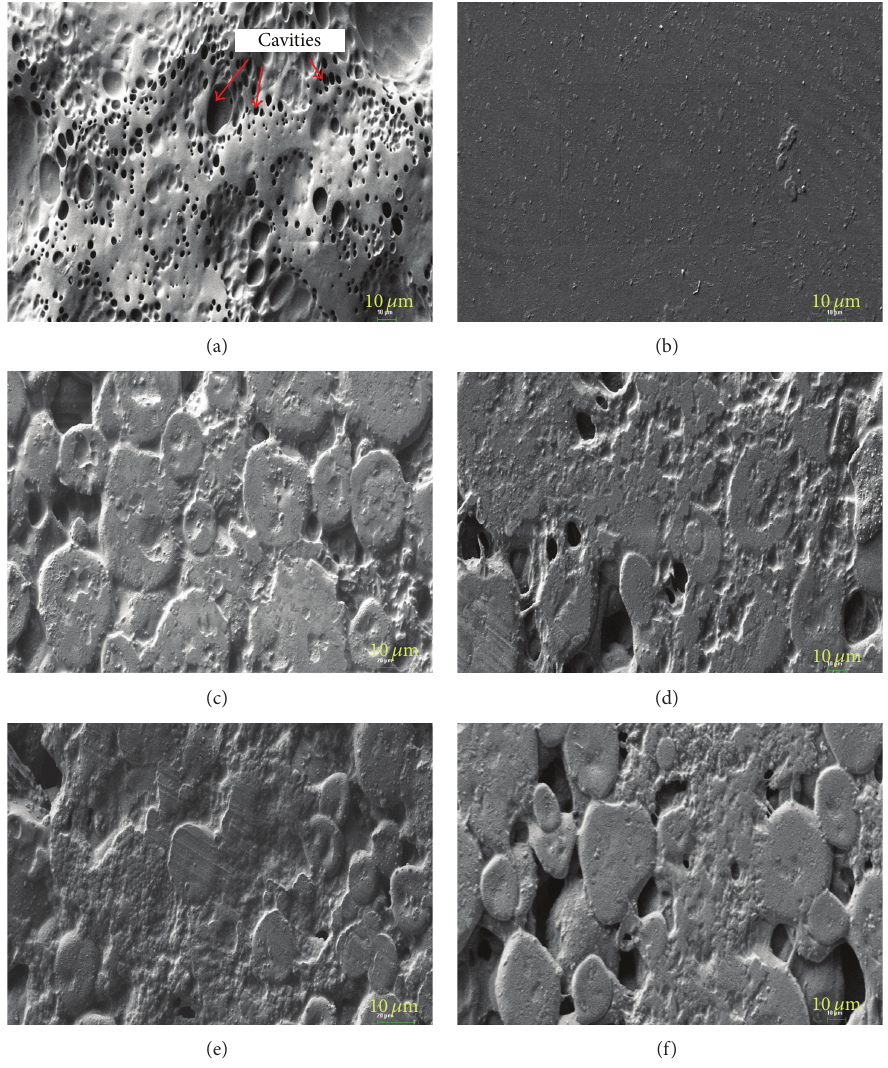
Figure 1: SEM micrograph showing surface morphology of (a) PVC, (b) PHA SPKO , (c) PSP 2.5 , (d) PSP 5 , (e) PdegSP 2.5 , and (f) PdeSP 5 films (500x